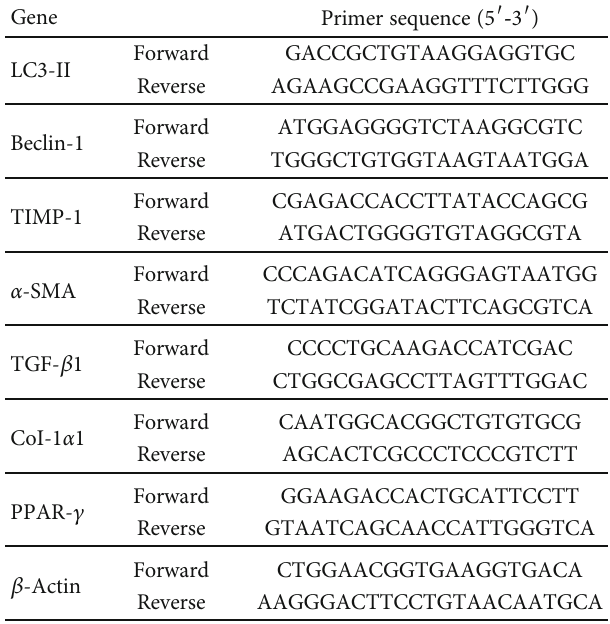
Table 1: Nucleotide sequences of primers used for qRT-PCR.